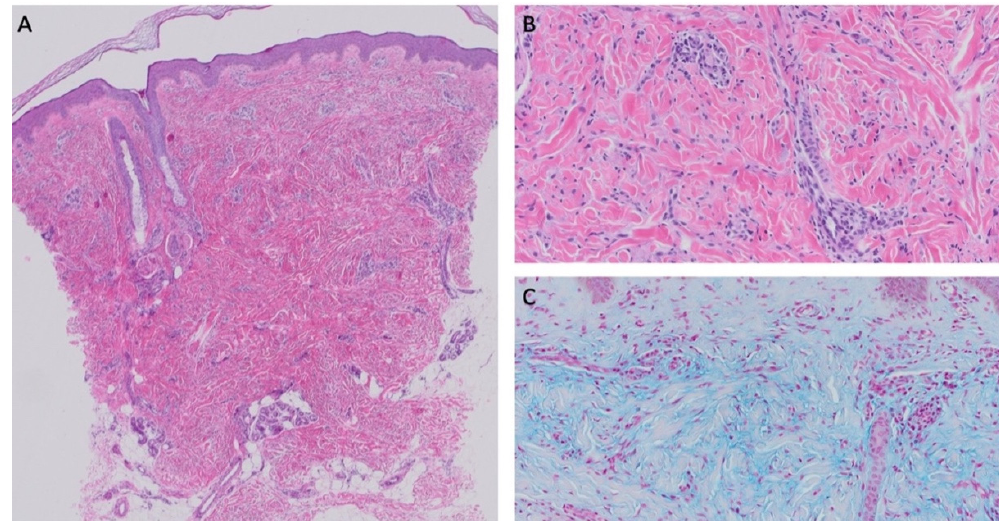
Figure 4. H&E, original magnification × 4 ( A ) and H&E original magnification × 20 ( B ) showing superficial and mid-dermal spindle cell proliferation with increased dermal mucin deposition. H&E, original magnification × 20 with Alcian blue stain highlights the dermal mucin deposition ( C ). Treatment of her lesions with fluocinonide and mometasone creams was unsuccessful. Given that her lesions are asymptomatic, further treatment was deferred. New lesions continue to develop without spontaneous resolution over 2-year